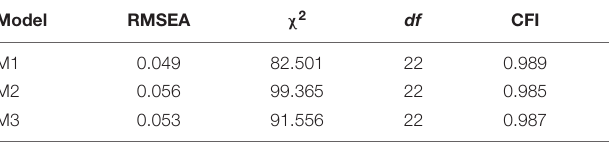
TABLE 2 | Goodness of fit indices of additional models ( n = 1,151). Model